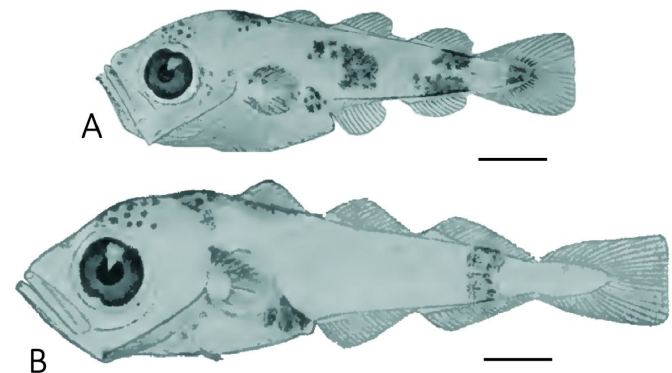
Figure 1. Illustrations of Gadiculus post-larvae at the same stage of development by Schmidt [17]. ( A ). Gadiculus argenteus ; ( B ). Gadiculus thori . The post-larvae were originally used to distinguish two different species although largely neglected in subsequent works until this study. Scale bars: 1 mm.